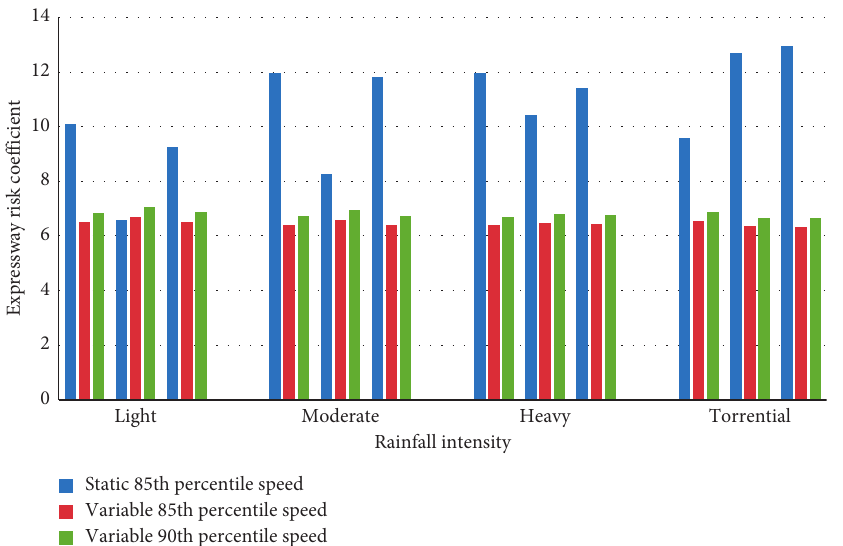
Figure 5: Expressway risk coefficient with different speed limit methods under different rainfall